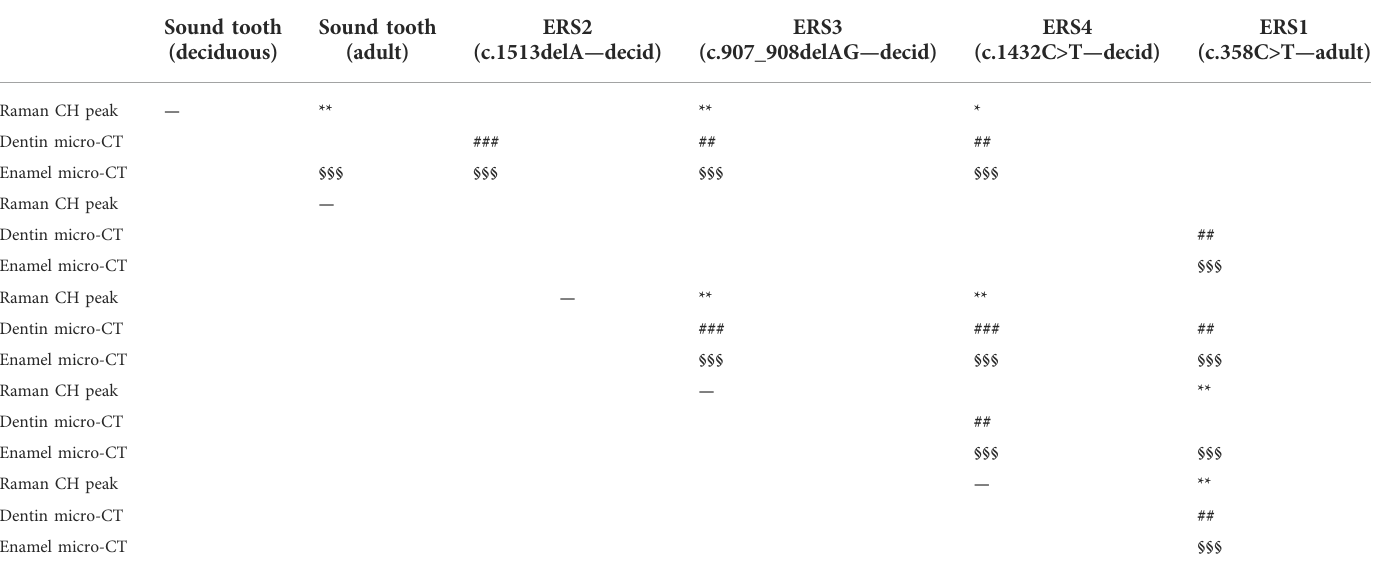
TABLE 2 Statistical difference measurement between sound and ERS